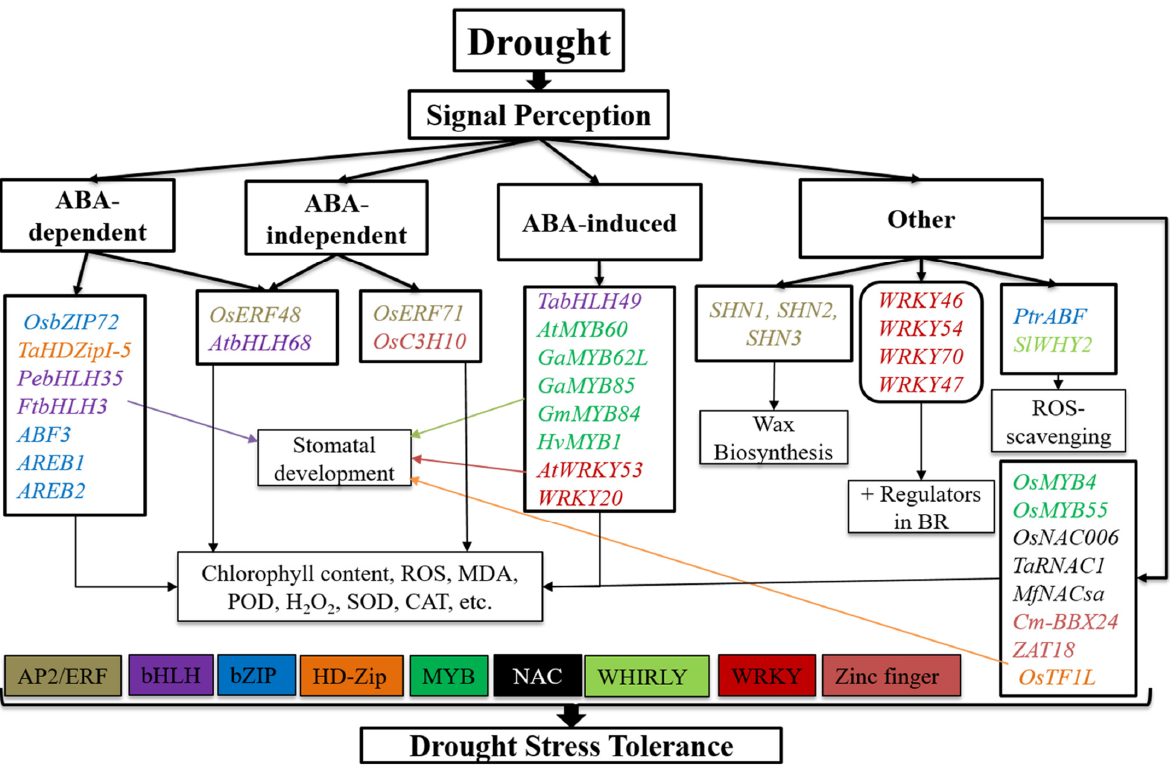
Figure 2. Genes and signaling pathways that regulate drought stress tolerance. These pathways include the AP2/ERF, bHLH, bZIP, HD-Zip, MADS-box, MYB, NAC, WHIRLY, WRKY, and zinc finger. These regulators control drought stress tolerance through ABA-independent and -induced pathways, which play an essential role in ROS-scavenging pathways. They are positive regulators in the BR pathway, enable wax biosynthesis and stomatal development, and alter chlorophyll, MDA, POD, SOD, and CAT content. Different text colors represent different transcription factors. Furthermore, its overexpression in Arabidopsis caused more leaves and a greater leaf area and increased the primary root length [53]. The wheat TabHLH49 gene is drought stress-related bHLH TF that positively regulates the dehydrin WZY2 gene and improves drought tolerance in wheat [54]. The rice OsbHLH068 gene is a member of the bHLH TFs, part of the ABA-dependent pathway, and delayed seed germination and late flowering. OsbHLH068 overexpression in Arabidopsis resulted in late flowering, delayed seed ger- mination, decreased salt-induced H 2 O 2 accumulation, increased MDA, and promoted root elongation [55]. The rice OsbHLH035 bHLH TF is involved in germinating seeds and ena- bling the recovery of seedlings from salt stress through the ABA-dependent and ABA- independent pathways. After overexpression of the OsbHLH035 gene, seed germination was delayed, and the average growth of Arabidopsis seedlings recovered after salt stress [56] (Figure 3, Table 1). It is well reported that bHLH TFs play essential roles in gene reg- ulation in many plant species under various abiotic stressors [57]. Arabidopsis AabHLH35 , a bHLH gene, conferred cold and drought tolerance to A. andraeanum and might also help bring tolerance to various abiotic stressors in other ornamental species. AabHLH35 trans- genic Arabidopsis plants better tolerated both cold and drought stress [57]. AtbHLH112 is a bHLH TF induced by abscisic acid, drought, and salt stress. Arabidopsis plants overex- pressing AtbHLH112 had enhanced salt and drought tolerance, caused by various physi- ological modulations, including higher proline accumulation and enhanced antioxidant enzyme activities to curb ROS damage [58].